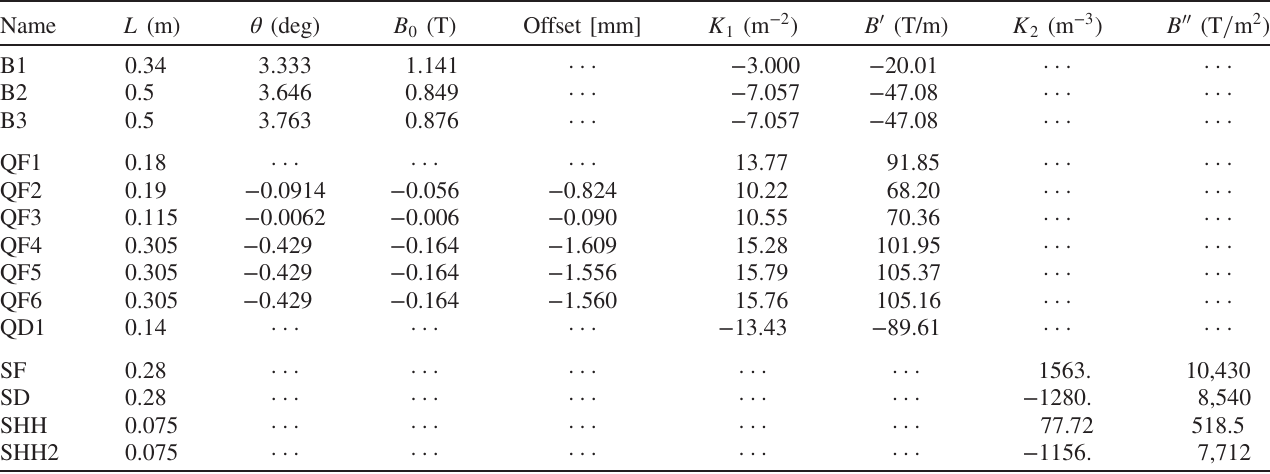
TABLE II. Baseline-lattice normal sector specifications for the magnets ’ effective length L , bending angle θ and field B 0 , quadrupole and sextupole unnormalized B 0 , B 00 and normalized K 1 , K 2 (MAD convention) gradient-field components. All magnets have two counts